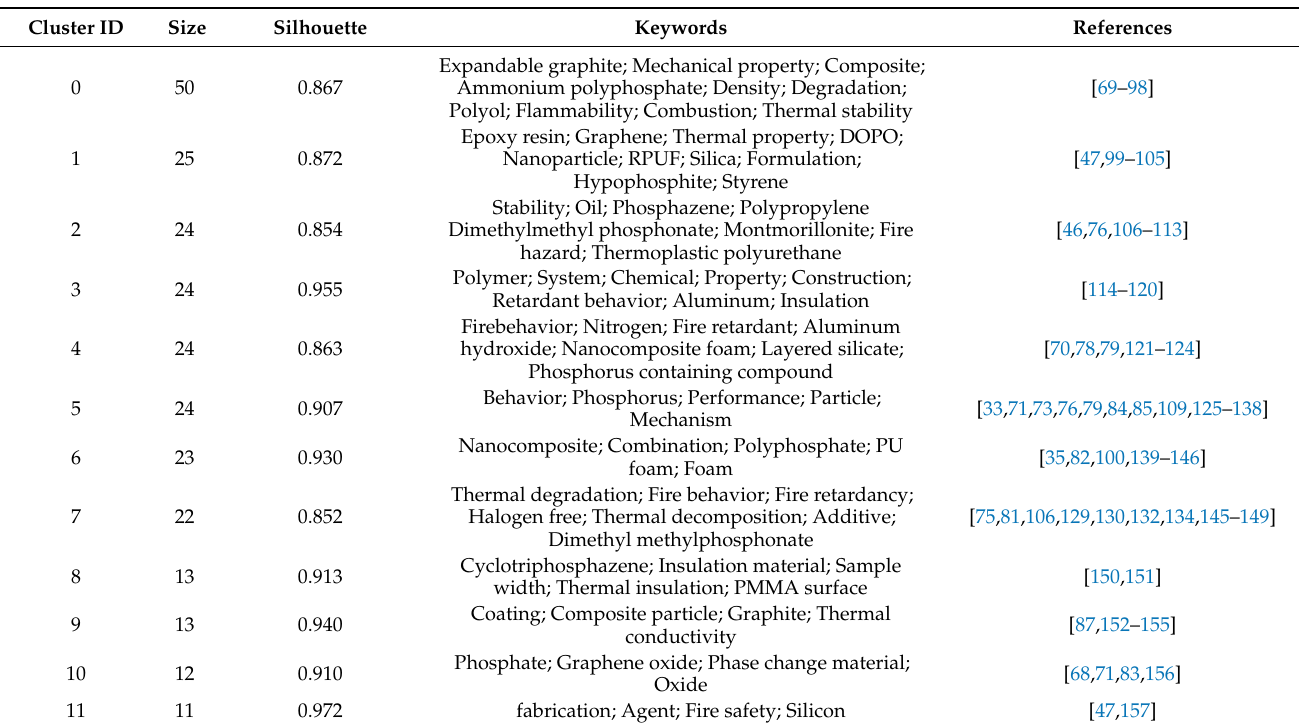
Figure 10. Grouping of keywords for flame-retardant RPUF. Table 4. Knowledge clusters in the theme of flame-retardant RPUF on keyword co-occurrences for each